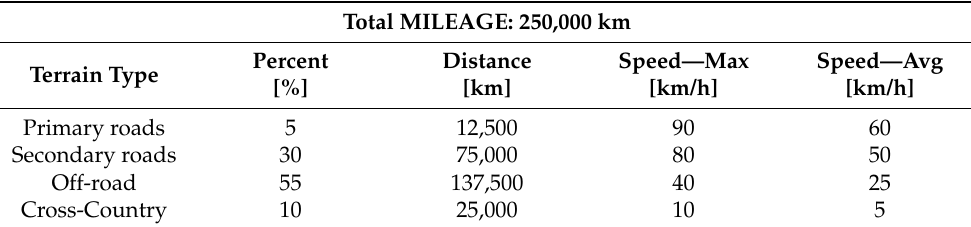
Table 1. Life Cycle Environmental Profile of High-Mobility Wheeled Vehicle (example)